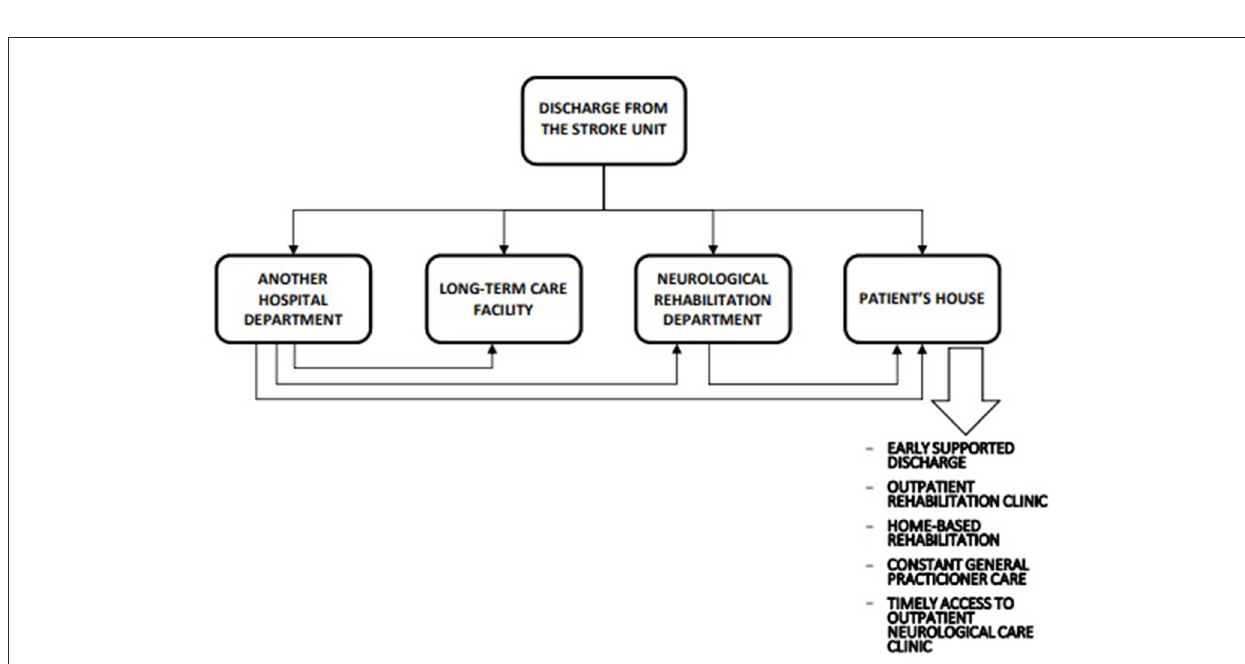
FIGURE2 Optimal postacute stroke care pathway (unpublished - drawn by Jarosław Ge˛bski, Polish Society of Health Economics, Warsaw,